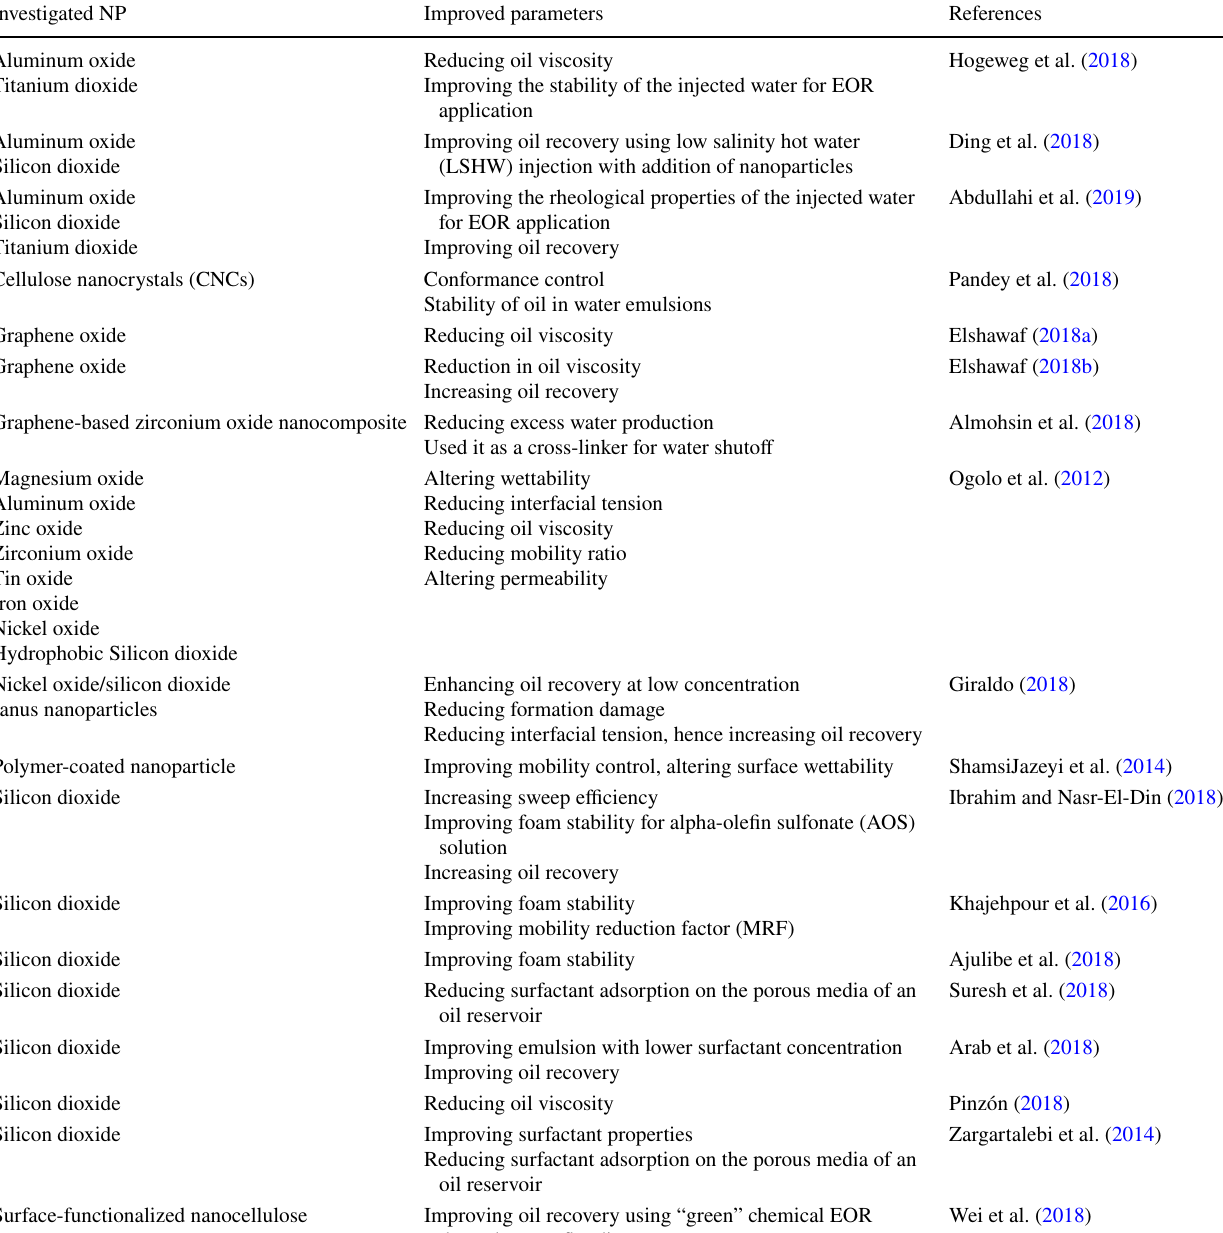
Table 1 Application of nanoparticles for EOR Investigated NP Improved